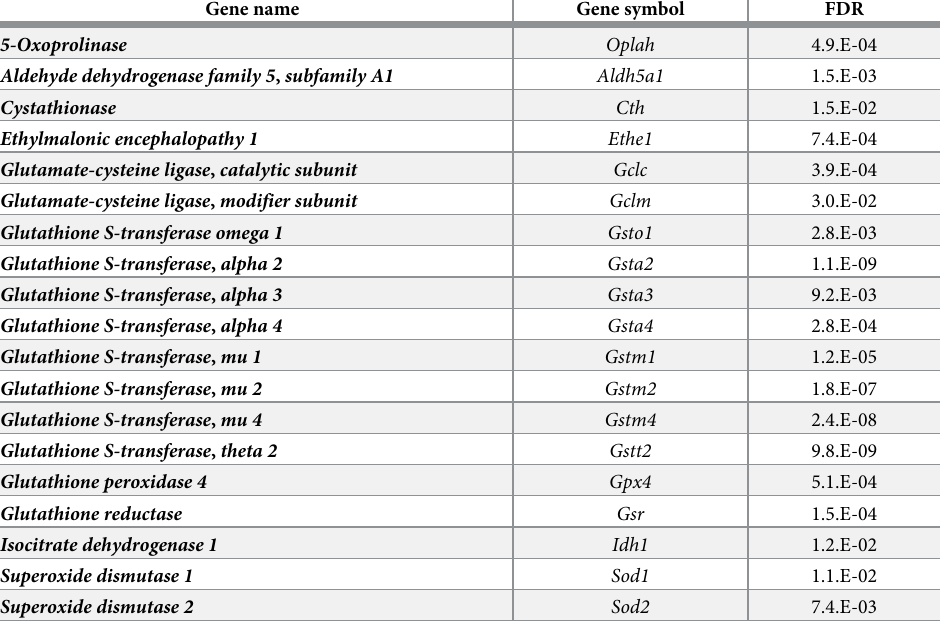
Table 1. Upregulated genes related to the glutathione metabolic process that are altered in the liver following the consumption of an iso- α -acids diet by a DNA microarray analysis. Gene